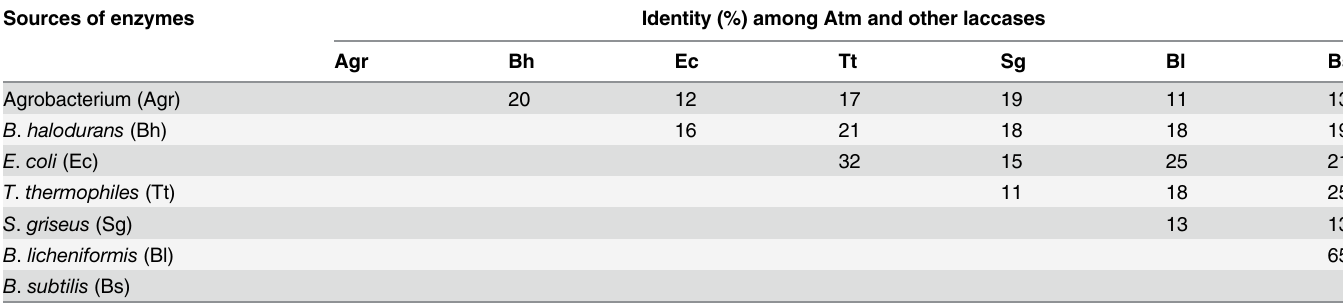
Table 1. Identity (%) of Atm from Agrobacterium (Agr) with other published bacterial laccases as calculated by ClustalX. Sources of enzymes Identity (%) among Atm and other laccases Agr Bh